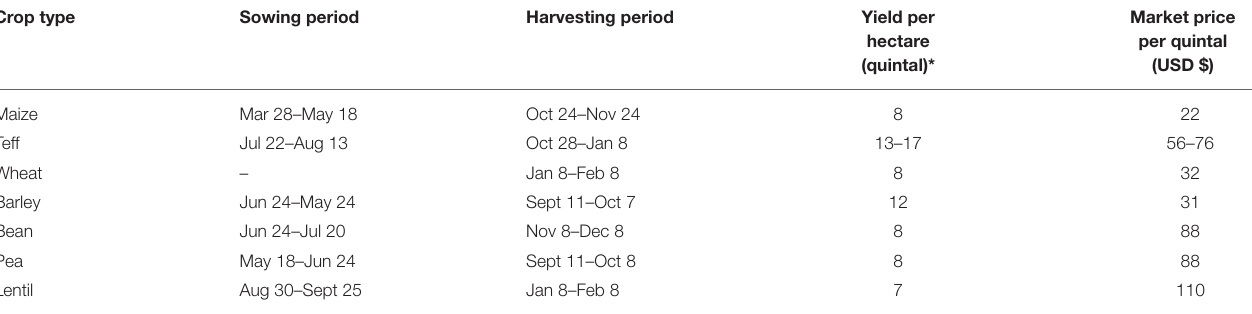
TABLE 4 | Characteristics of major crops identified by both men and women (Source: Own